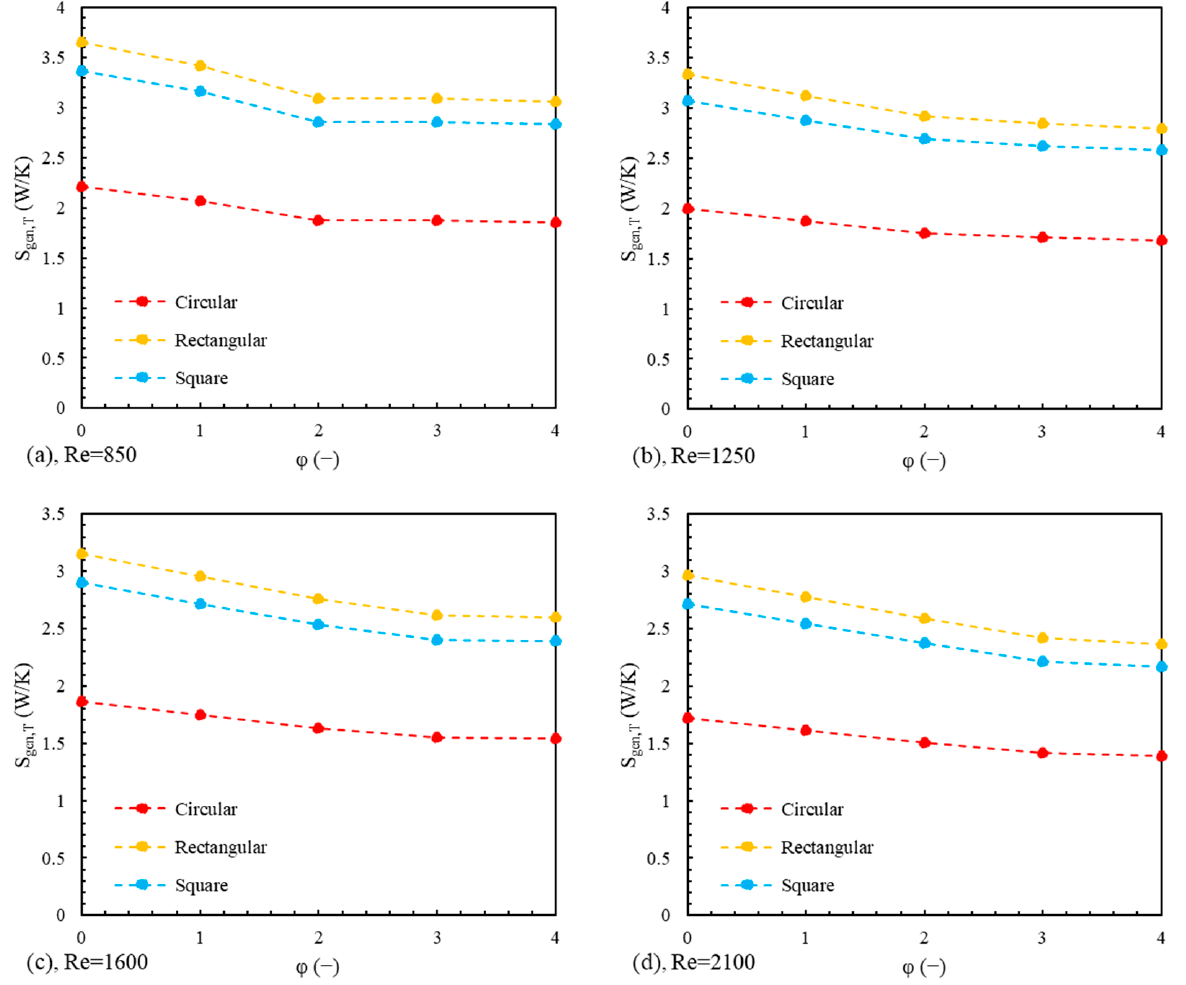
Figure 14. Total entropy generation in all cross-sections for different fluids in ( a ) Re = 850, ( b ) Re = 1250, ( c ) Re = 1600, and ( d ) Re = 2100.